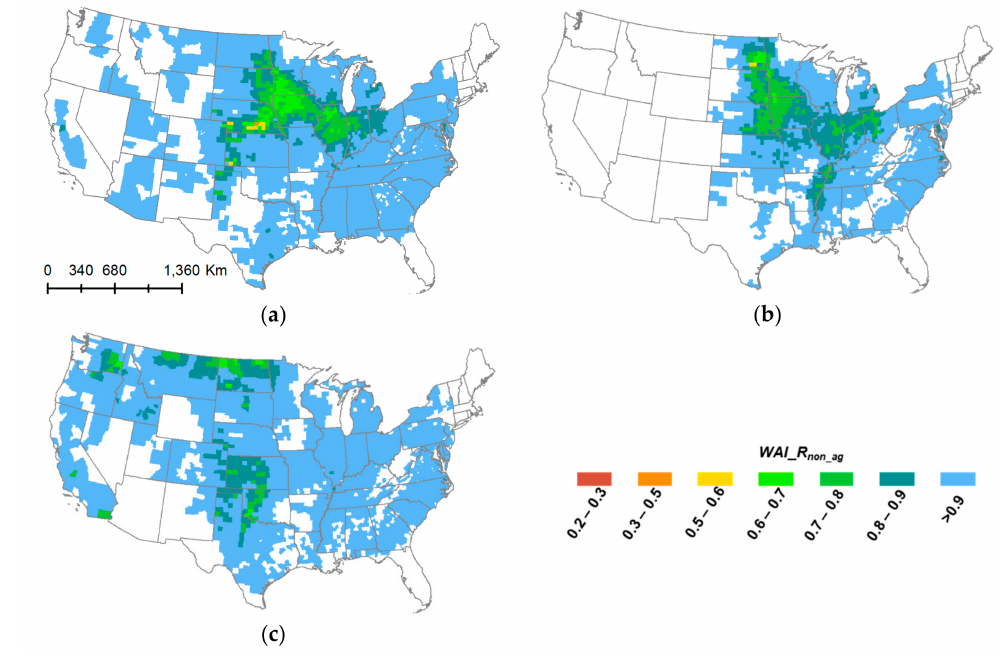
Figure 8. County-level crop specific WAI_R non_ag values based on harvested acres of ( a ) corn; ( b ) soybeans; and ( c ) wheat (including spring and winter wheats). Harvested acres include total production for all purposes (food, feed, and fuel) in 2008 in the U.S. Panels show green water resources available for other crops and sectors after meeting the crop water demand of corn, soybean, and wheat production. The spatial pattern of crop-specific WAI_R non_ag does not mean crops in the Midwest use more water on a per-unit biomass basis. In fact, county-level CWD (m 3 /d.s.t) of the three crops (Figure 9) clearly indicate that counties in the Corn Belt are more water efficient than other areas. In addition, it seems that some counties located in northwestern states (Washington, Portland, Idaho, Oregon) are also water efficient in terms of corn and wheat production. Relatively low WAI_R non_ag values in these counties suggest it would be possible to increase crop acreages in these counties from a green water resource perspective, but land-use changes may cause other problems (e.g.,